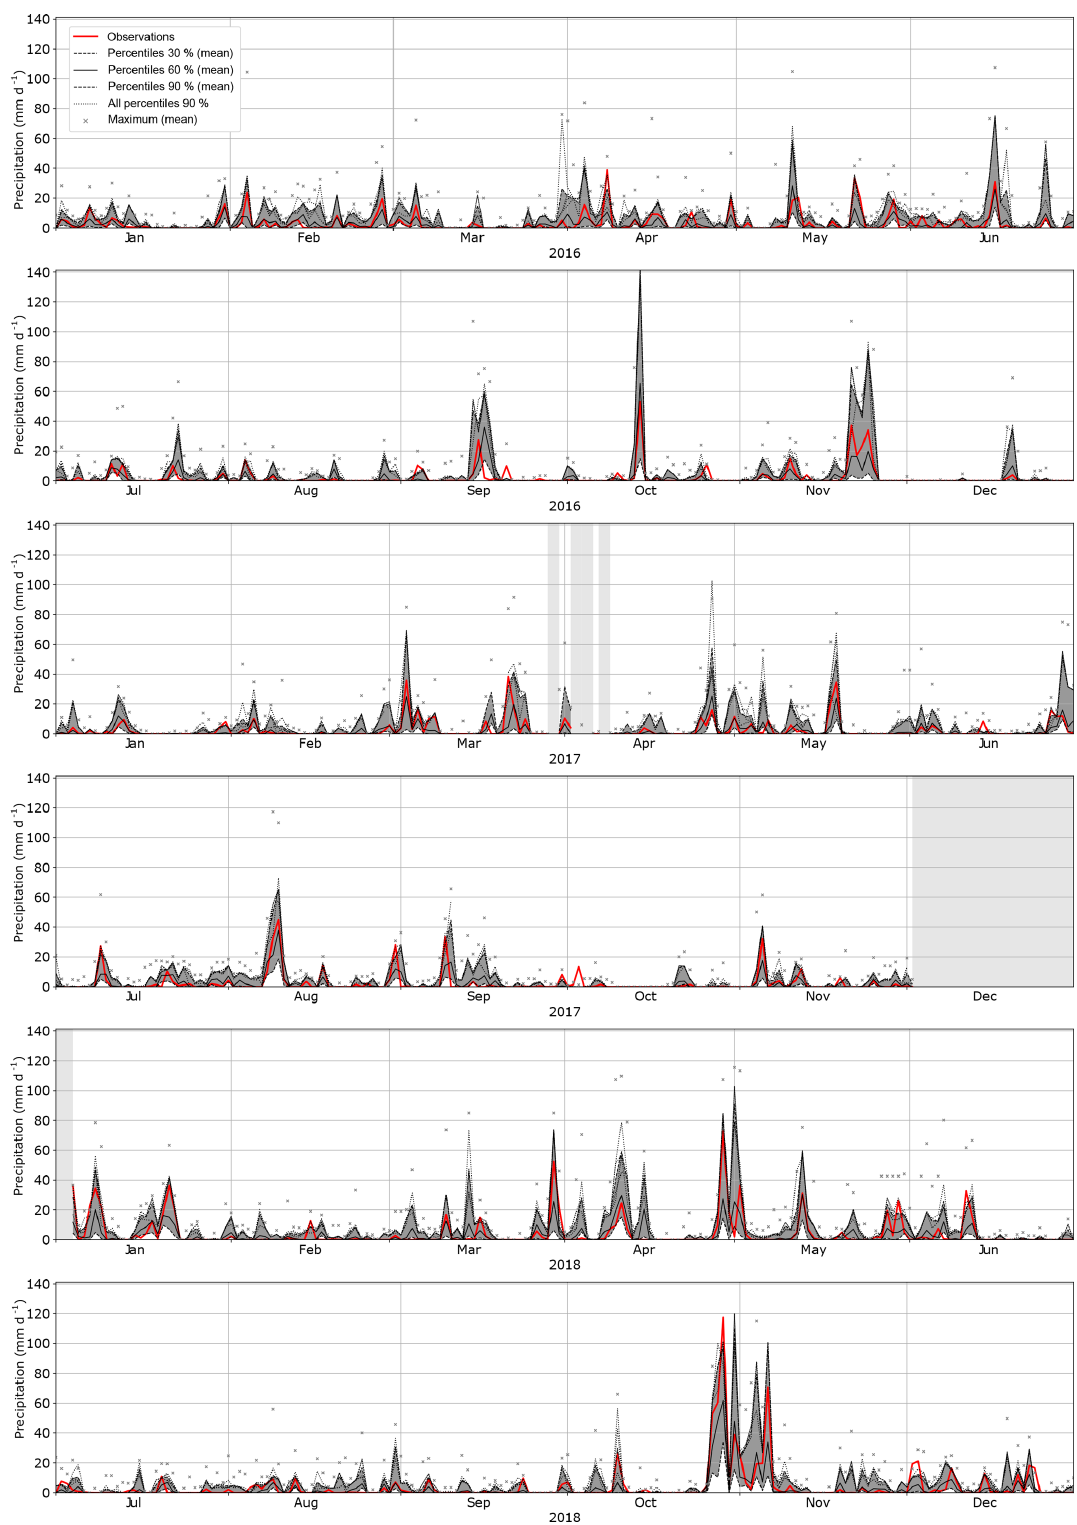
Figure 11. Same as Fig. 10 but for the 4Zo-2MIo method (Table 2) with a lead time of 1d.